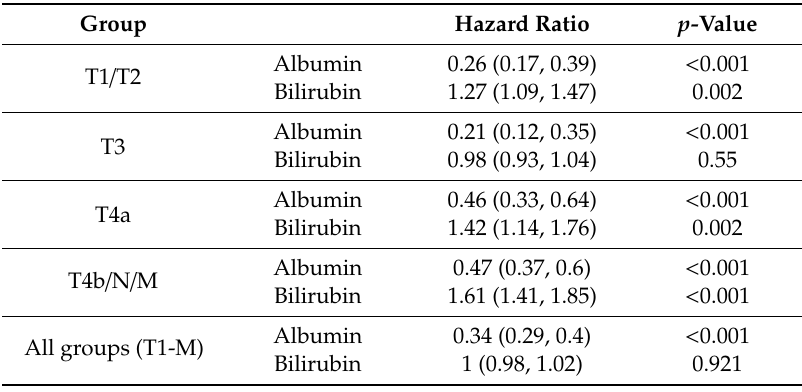
Table 6. Cox Proportional hazards of albumin and bilirubin as continuous variables. Group Hazard